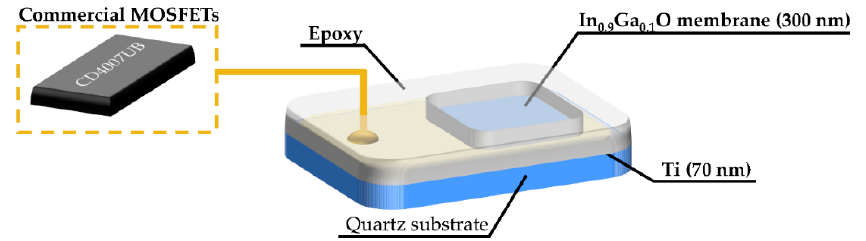
Figure 1. Schematic diagram of sensing structure.